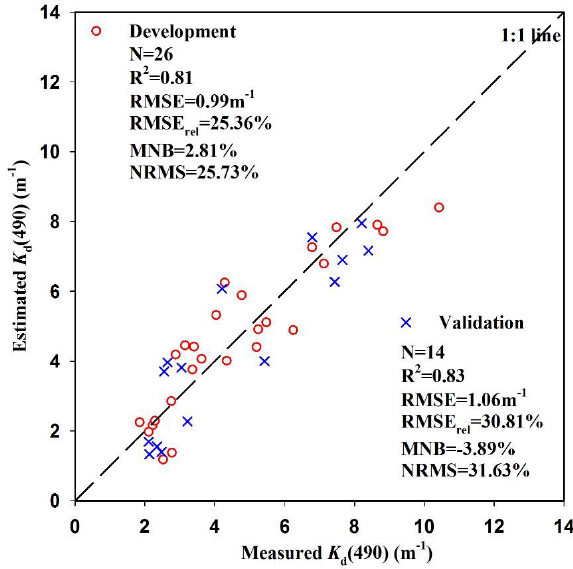
Figure 5. Development and validation of the algorithm for estimating K d (490) in Lake Taihu from the OLCI-derived R rs .